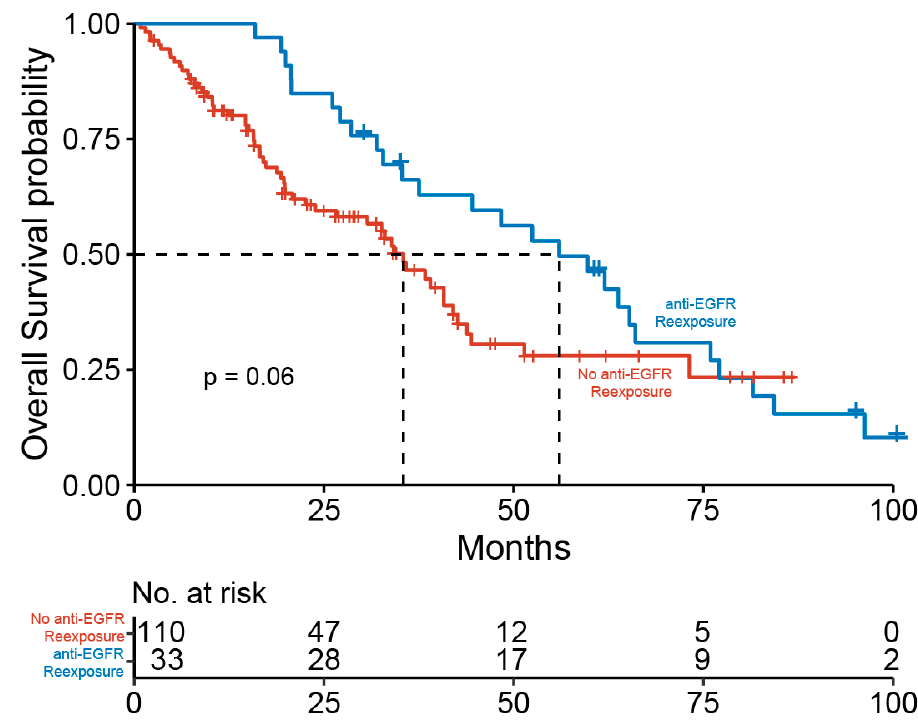
Figure 3. Kaplan-Meier estimator for the overall survival in patients receiving anti-EGFR-based therapy stratified by anti-EGFR re-exposure (blue) versus no anti-EGFR re-exposure (red).